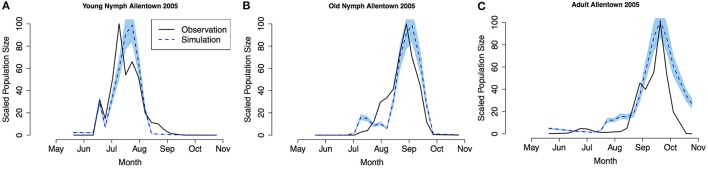
Model validation in Allentown, PA 2005 (A) young nymphs (1st–3rd instar), (B) old nymphs (4th96-5th instar), (C) adult. Shaded area represents 95% CI (confidence interval) for predictions from 100 simulations.